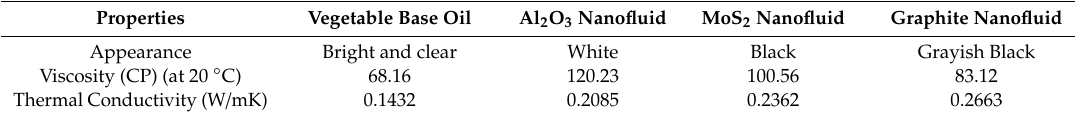
Table 4. Properties of di ff erent nanofluids [26].